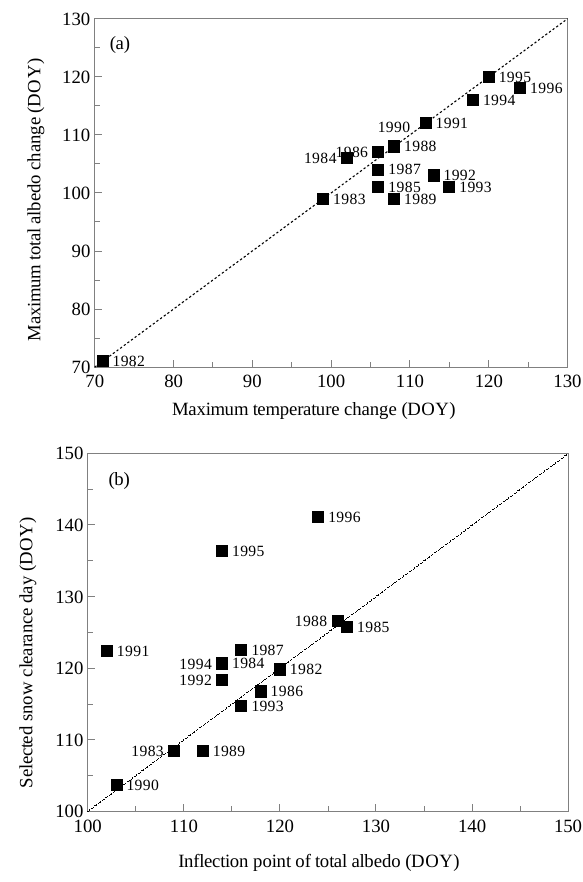
Figure 7. (a) Correlation between maximum temperature change day (DOY) and maximum total albedo change day (DOY); (b) cor- relation between inflection day of total albedo (the day when surface albedo just finishes a fast decrease from its wintertime level; DOY) and the snow clearance day (DOY). The plots show regional means over subregion1 for all